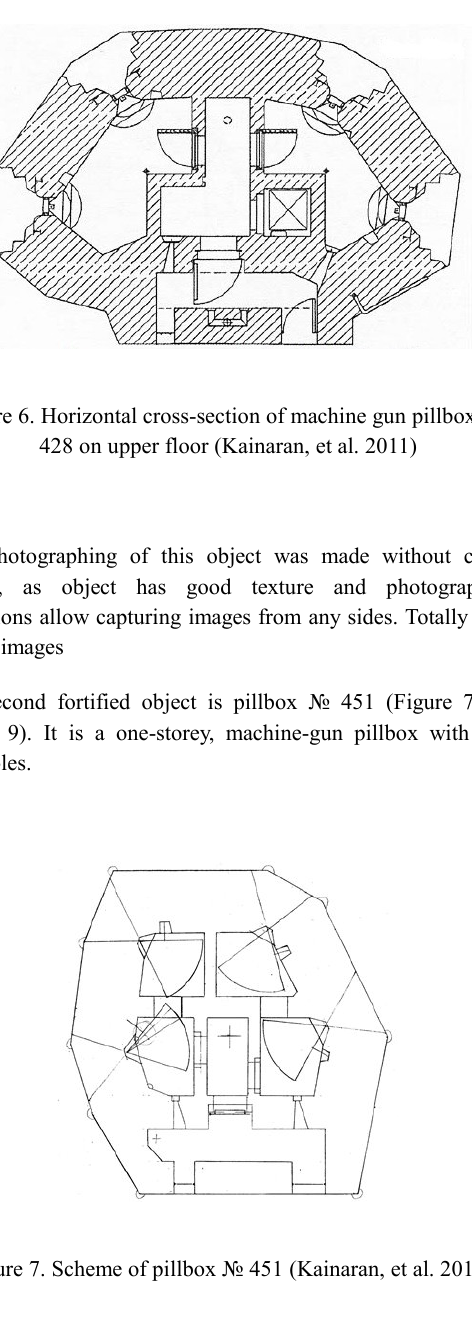
During the liberation of Kiev in 1943 the object was partially destroyed. The photographing of this object was made with 16 bit coded targets, as object has not so good texture as in the first case and photographing possible only from particular sides due to trenches and trees. Totally were got 45 images.